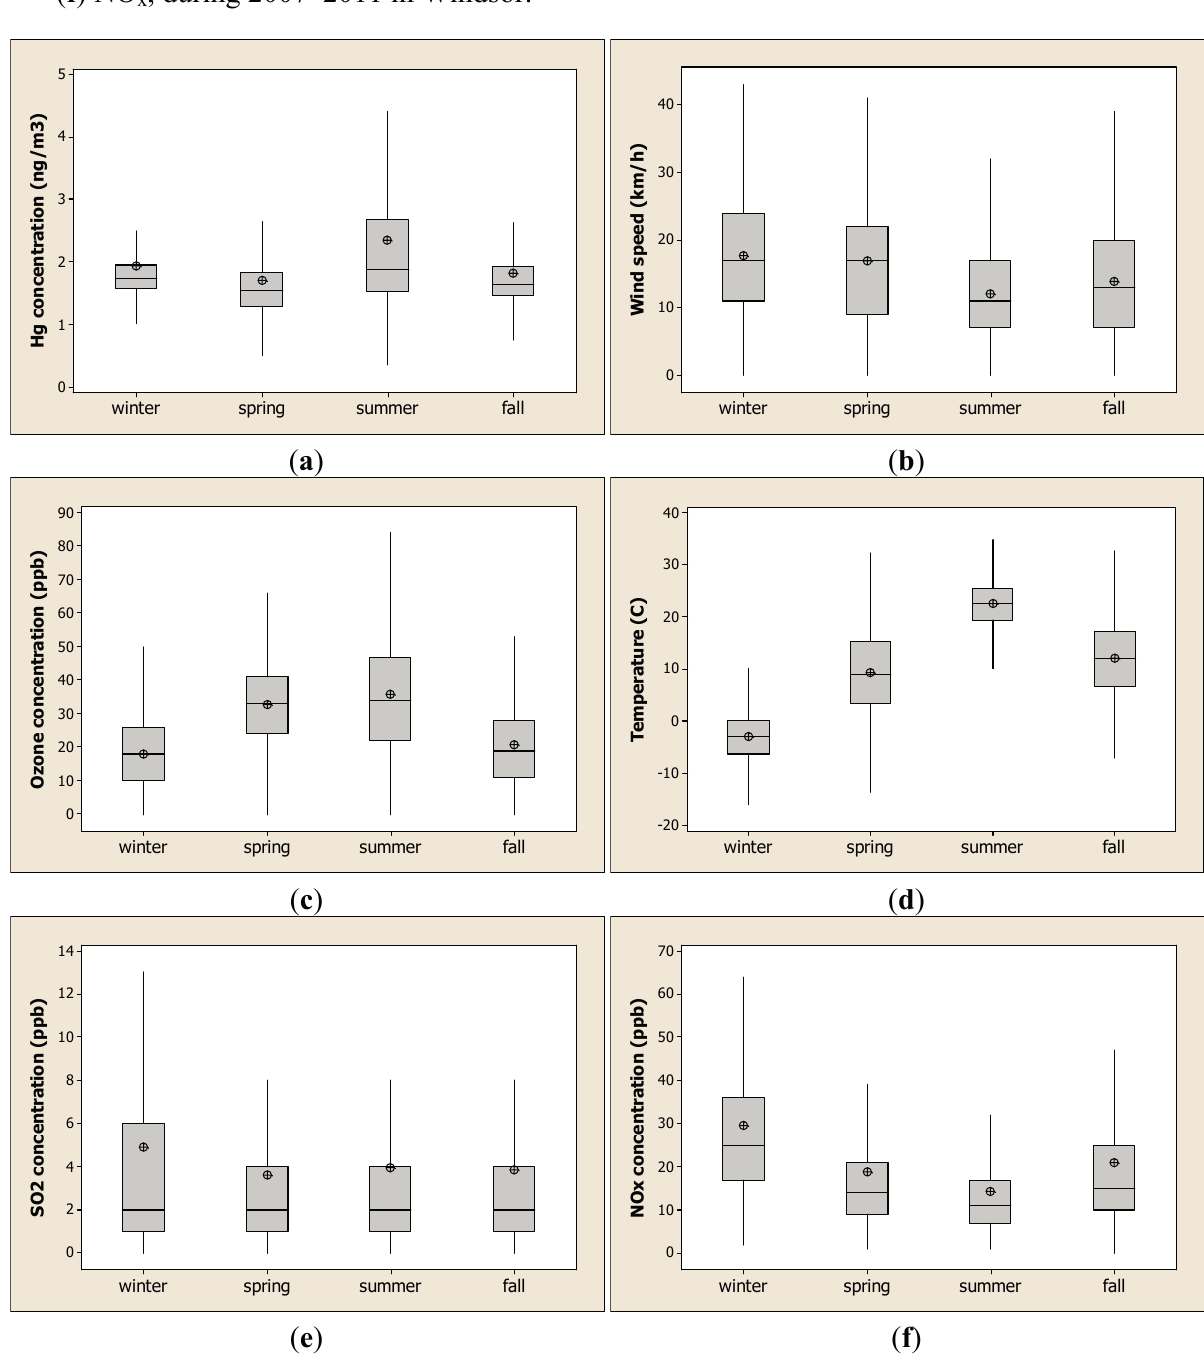
Figure 3. Box plot of seasonal ( a ) TGM, ( b ) wind speed, ( c ) O ( f ) NO , during 2007–2011 in x